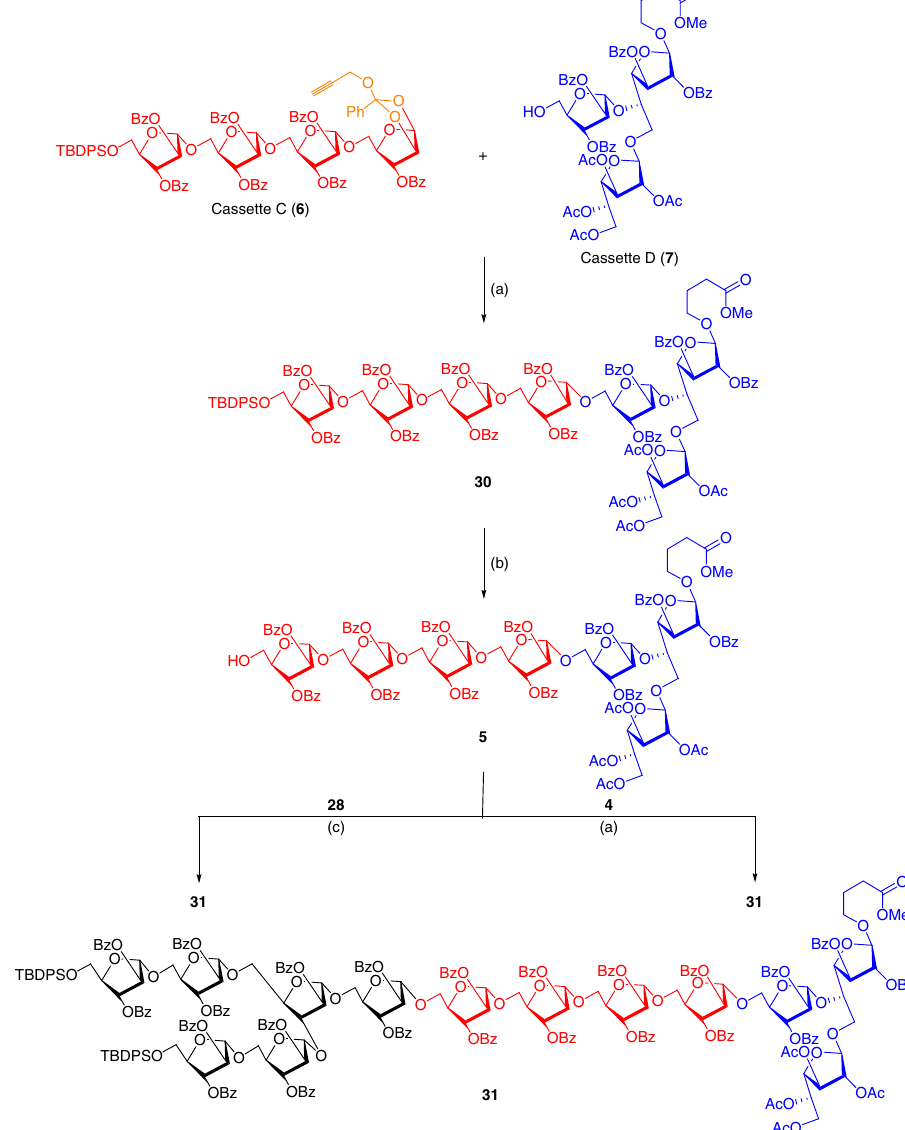
Figure 8 | Synthesis of tridecaoligofuranoside. Reagents and conditions: (a) AuCl 3 (7mol%), AgOTf (7mol%), CH 2 Cl 2 , 4Å MS powder, 25 (cid:2) C, 24h, 70% for 30 and 65% for 31 . (b) Py (cid:2) HF, THF:Py (5:1), 0 (cid:2) C - 25 (cid:2) C, 4h, 85% (c) NIS (3eq.), TfOH (0.3eq.), 4 days, 0 (cid:2) C - 25 (cid:2) C,